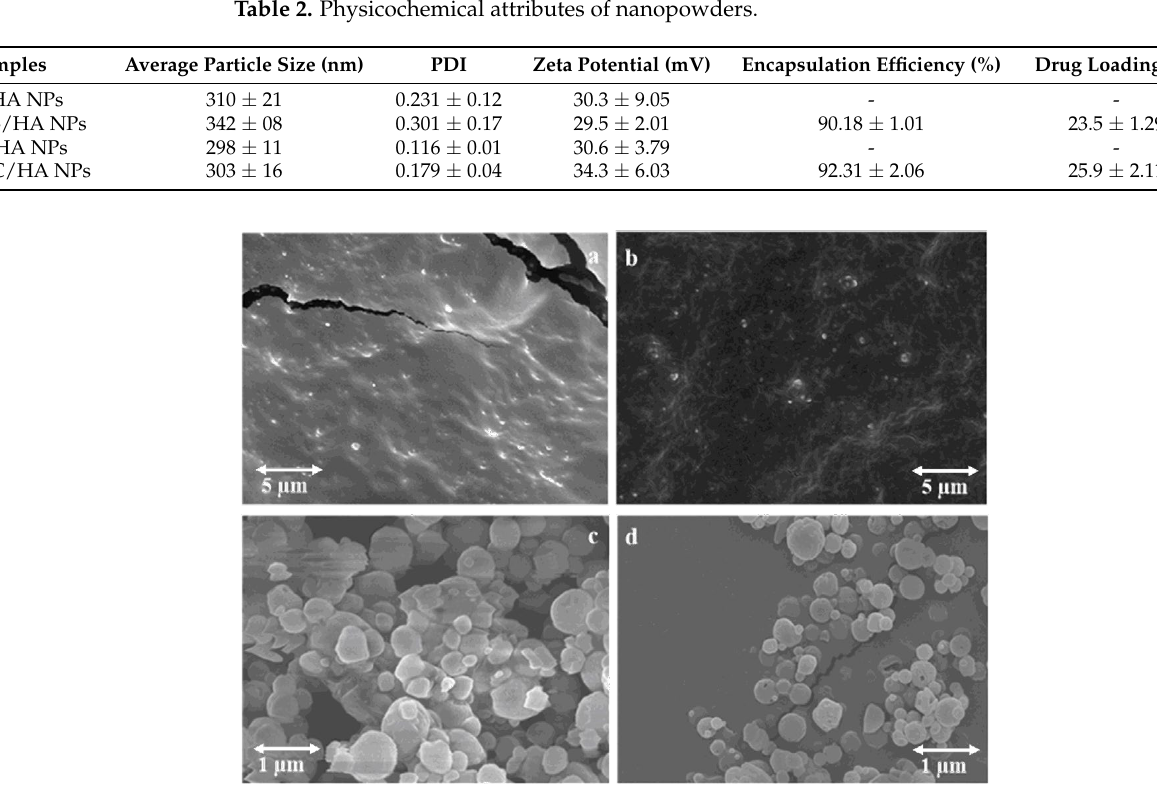
Table 2. Physicochemical attributes of nanopowders .